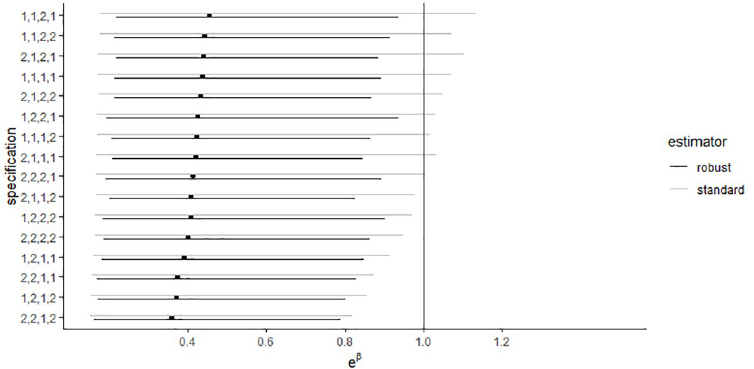
Fig 1. Multiverse analysis of the regression of consistency errors on data sharing in the original data set from Wicherts et al. The figure represents the point estimates and 95% confidence intervals for the exponentiated regression coefficients of the predictor shared for all combinations of analytical choices. The vertical line represents the absence of an effect ( e 0 = 1). The choice of variance estimator is indicated in black (robust) or grey (standard). On the y-axis, the other specifications are shown through a four-digit binary code. Each position refers to a decision and the specific number indicates which option has been chosen. The other four decision variables are: (1) natural logarithm of the number of statistics (1 = included in the model as predictor, 2 = included as exposure variable), (2) square root of the mean of the recalculated p -values (1 = included in model, 2 = not included), (3) journal (1 = not included in model, 2 = included), and (4) construction of the data set (1 = original data, 2 = original data without retractions). The original analysis is specification 1,1,1,1 in black.